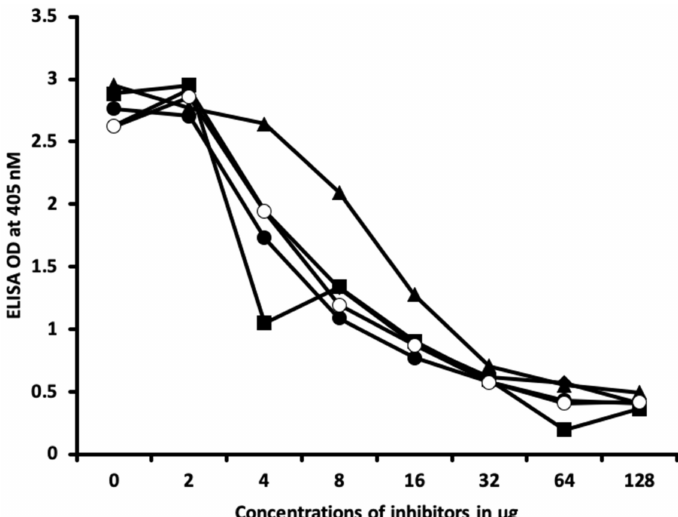
Figure 9. Binding of triiodothyronine antibody to parabens-HSA in the absence or presence of parabens-HSA, aflatoxin-HSA, formaldehyde-HSA, T-BPA-HSA, and TPA-HSA in concentrations of 0, = aflatoxin-HSA; (cid:4) = formaldehyde-HSA; (cid:78) = 2, 4, 8, 16, 32, 64, and 128 µ g / mL. (cid:7) = Parabens-HSA, (cid:35) T-BPA-HSA; • = TPA-HSA.